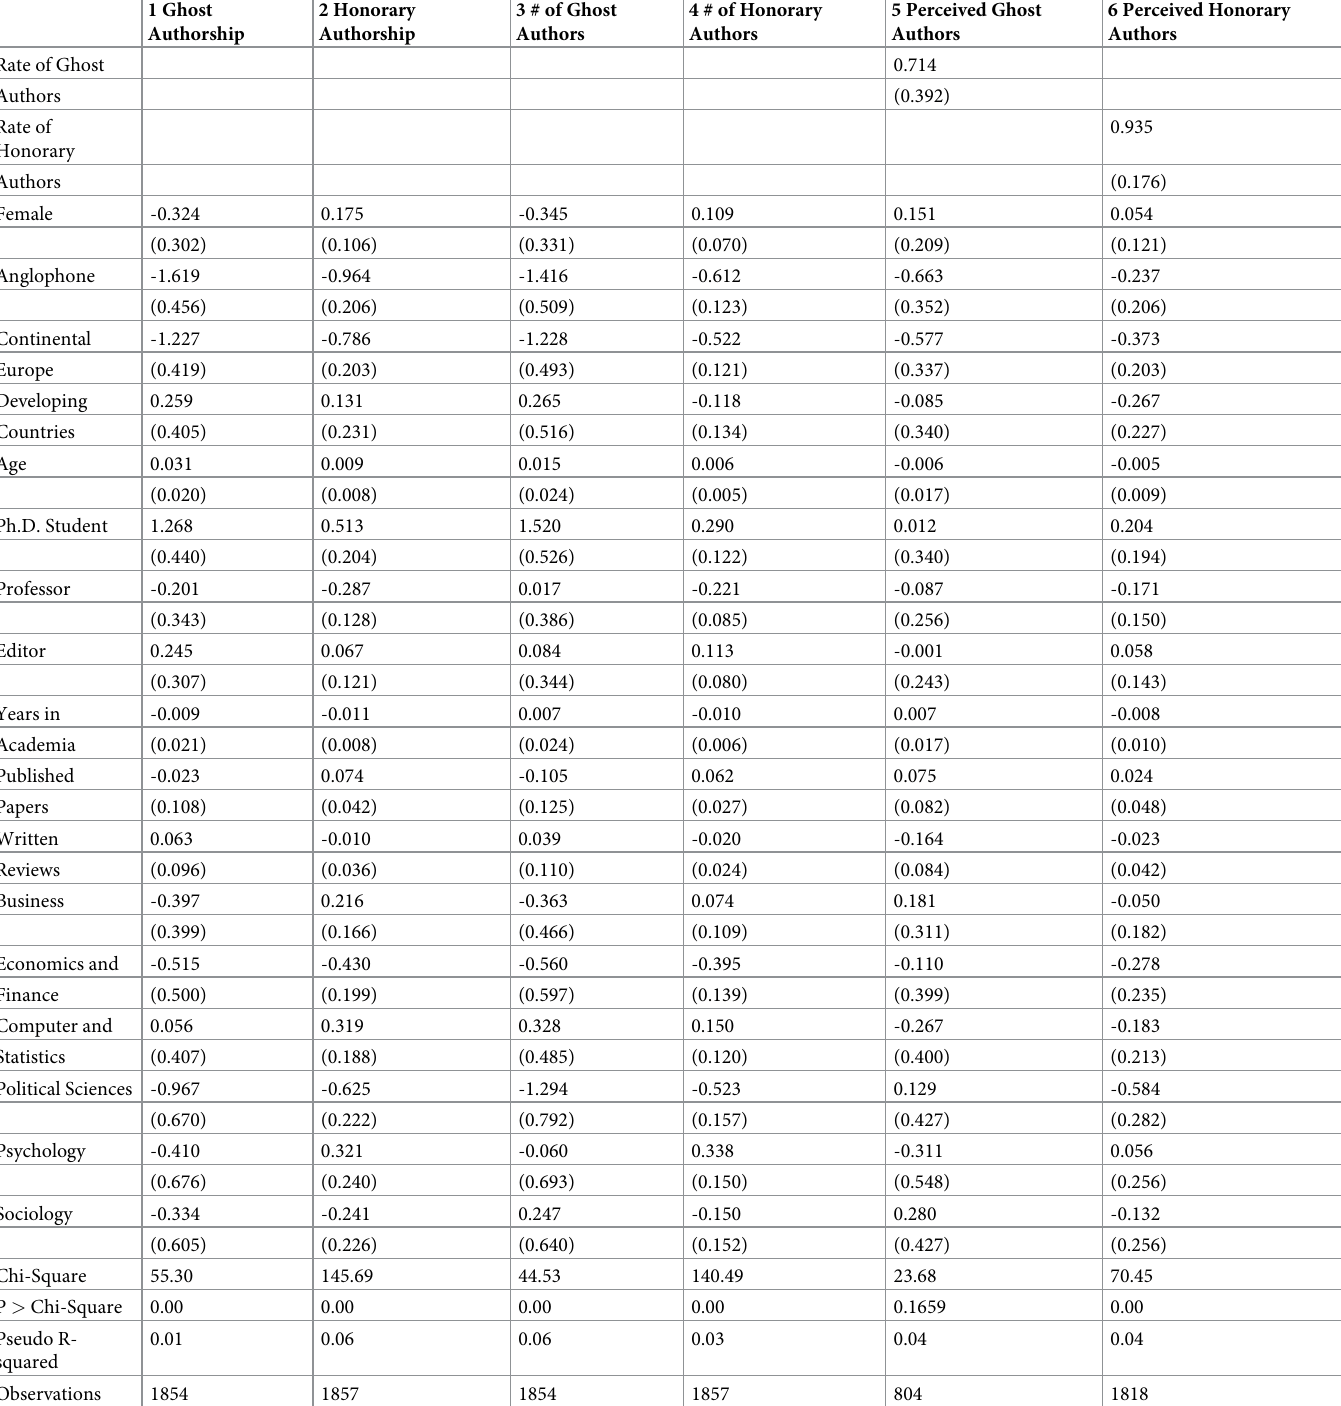
Table 1. Regression results of actual and perceived prevalence of ghost and honorary